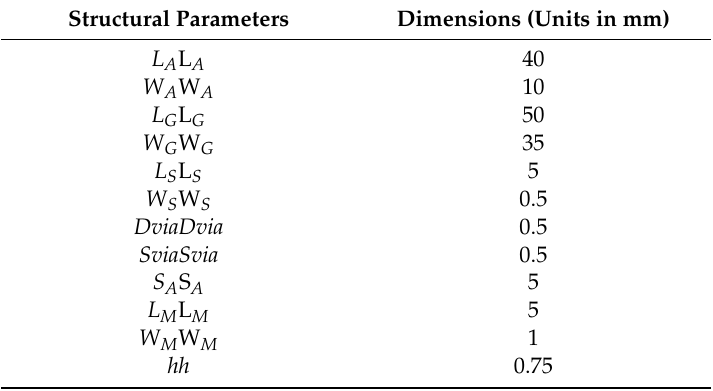
Table 1. Structural parameters of the